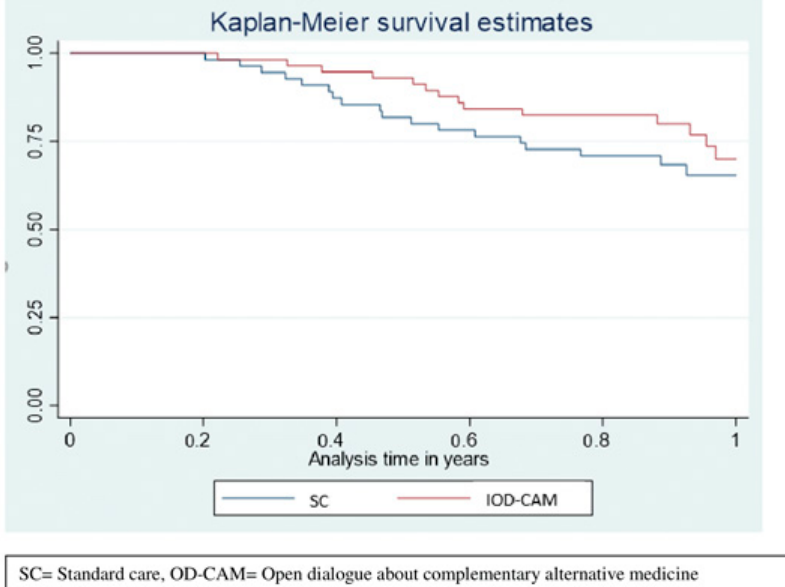
Figure 5. Restricted mean